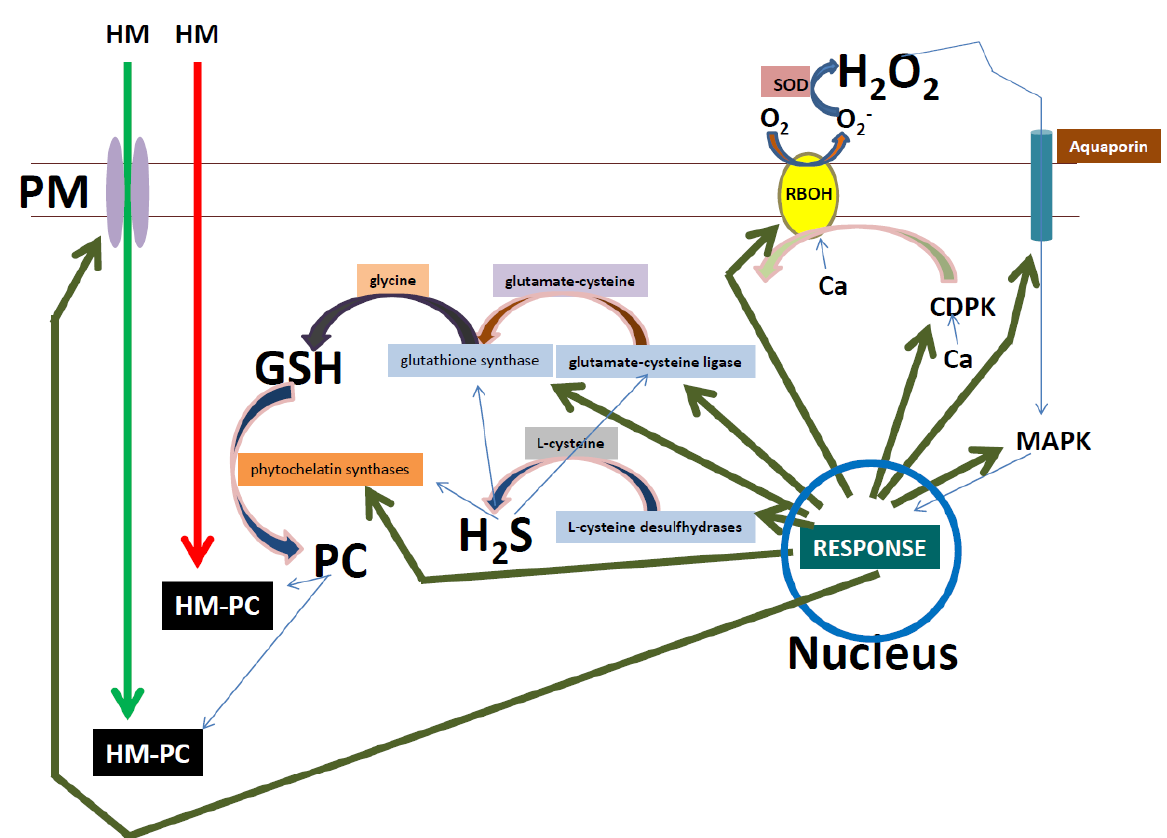
Figure 3. A schematic representation of the events following heavy metal (HM) reception at the PM. A nuclear activated CDPK phosphorylates and activates NADPH oxidase (RBOH) in the presence of calcium (Ca), which induces a superoxide (O 2 − ) burst in the apoplast. Superoxide dismutase (SOD) converts the O 2 − into hydrogen peroxide (H 2 O 2 ), which can be transported into the symplast via aquaporins. The H 2 O 2 can initiate a nuclear response through the activation of MAPK, which triggers downstream nuclear responses (dark green arrows) for protein synthesis. One of the products, L-cysteine desulfhydrases can produce hydrogen sulfide (H 2 S) from L-cysteine. In addition, the products glutamate–cysteine ligase and glutathione synthase can produce glutathione (GSH). H 2 S can also trigger an increase in GSH. Furthermore, another possible product, phytochelatin synthase, can convert GSH into phytochelatin (PC). The passive (red arrow) and active (green arrow) transported HM can bind to symplastic PC, forming a less toxic HM–PC complex. 13. Future Perspectives The fourth industrial revolution (4IR) started in Germany in 2011 [174] and has continued to spread rapidly to other parts of the world. Already, the increased improvement in robotics and artificial intelligence has contributed heavily to eliminating the separation of the physical world from the virtual world. Therefore, the combination of phenotyping technologies and the 4IR could increase our understanding of in-field plant responses to heavy metal stress. In order to make large scale accurate observations of heavy metal concentrations in plants grown close to contamination areas, nanotechnology sensors [175] could be used in combination with phenotyping-4IR. This would provide a large scale rapid safety assessment of heavy metal contaminated crops, and could contribute massively to providing safer foods for humans and animals. For improving plant crops to increase yield and production under heavy metal stress, a rapid understanding of the complex signaling mechanisms that govern the plant responses to the heavy metal stress is essential. Therefore, cutting-edge and high- throughput “ omics ” technologies , coupled with the 4IR, will be fundamental to understand the signaling processes that occur in plants under heavy metals at a definite time, and at cell-specific resolution. The high-throughput data obtained from these studies should be used in systems biology [176] to obtain the desired systems-level understanding of how